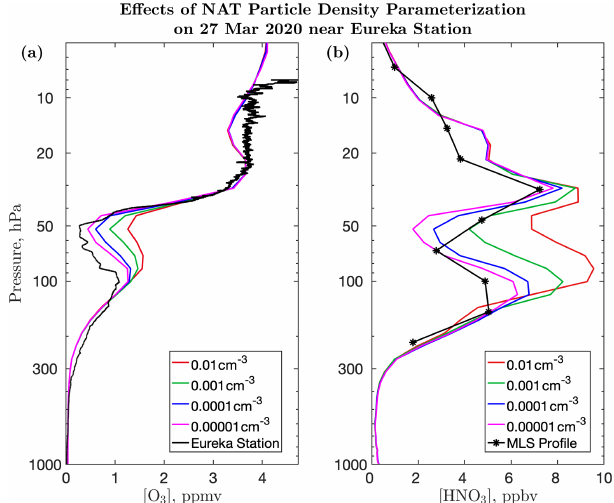
Figure 4. Comparison of ozone profiles (a) and nitric acid profiles (b) for four different SD-WACCM simulations at the grid point nearest Eureka Station for 27 March 2020, with ozonesonde data from Eureka Station shown for comparison in (a) and the nearest MLS profile on that day shown for comparison in (b) . Note that MLS has very few levels in the lower stratosphere (shown by black points). This is the same date as shown in Fig. 2b, and the magenta ozone profile corresponds to the dotted teal ozone profile shown in that figure.